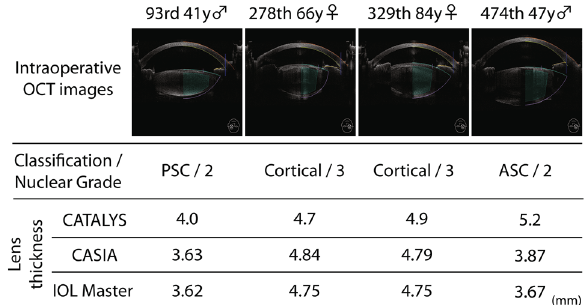
Figure 4. The details of cases with inappropriate PC lines. Four cases were classified as cases with inappropriate PC lines and their biometries were shown sequentially. In each of their intraoperative OCT images, the pure biometry images are shown on the left half of the image and the integrated images with the surgical laser area are shown on the right. In the second row, the classification of cataract and nuclear grade according to Emery- Little classification were described. Their lens thicknesses are shown in the third row. Except for the 278th case, three of them had longer lens thickness measured by CATALYS than other devices. The 93rd case and the 329th case are saved by the safety margin settled as 500 μm but posterior capsule rupture due to laser irradiation were occurred on the 474th case. (PSC; posterior sub-capsular cataract. ASC; anterior sub-capsular cataract, Cortical; cortical